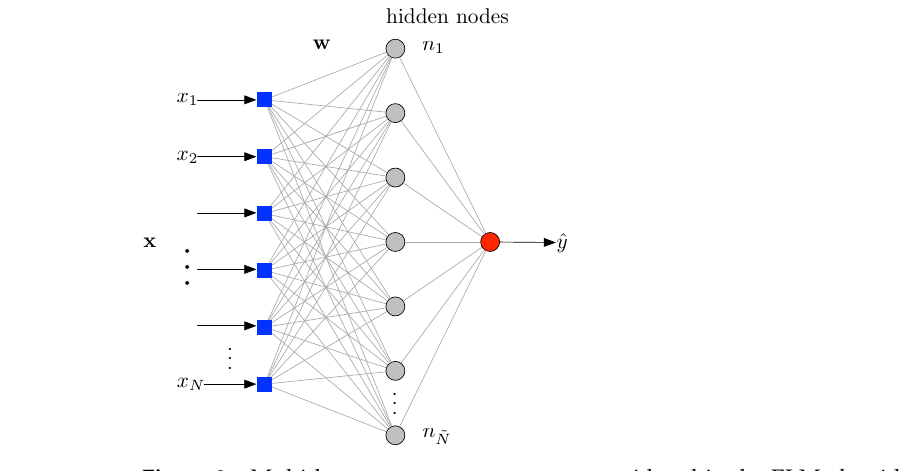
Figure 3. Multi-layer perceptron structure considered in the ELM algorithm. It has N different inputs and the hidden layer is composed by ¯ N